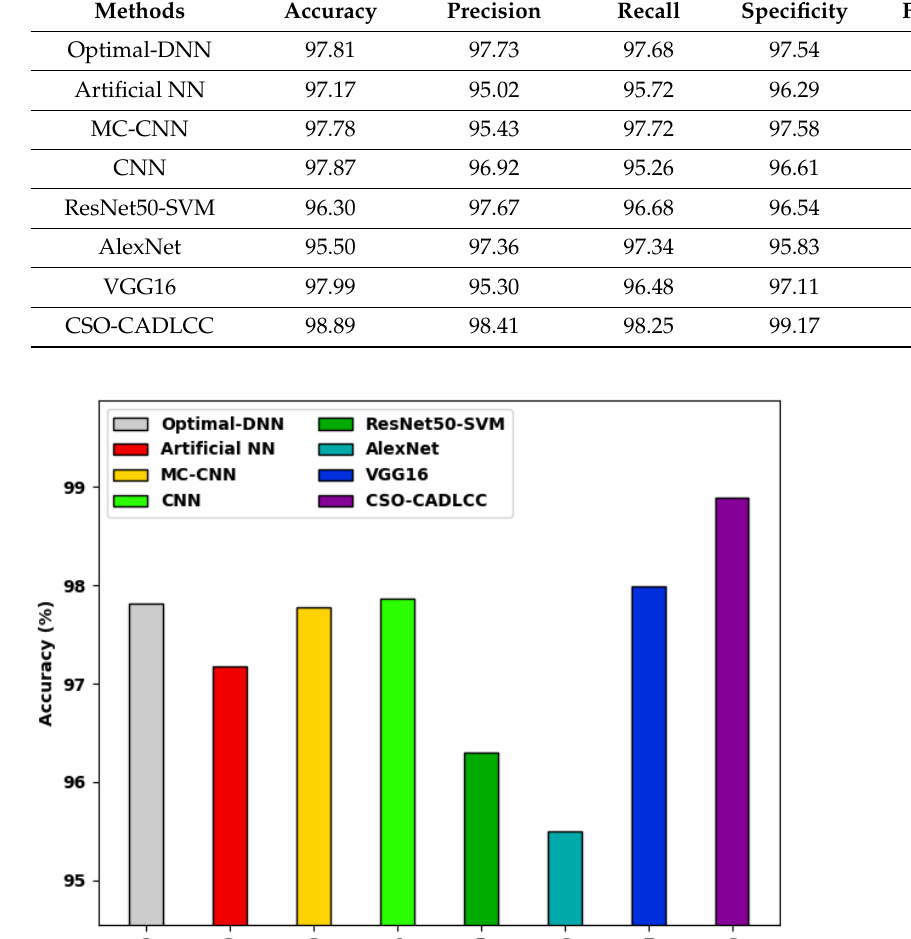
Figure 8. Accuracy analysis of the CSO-CADLCC technique with recent algorithms.